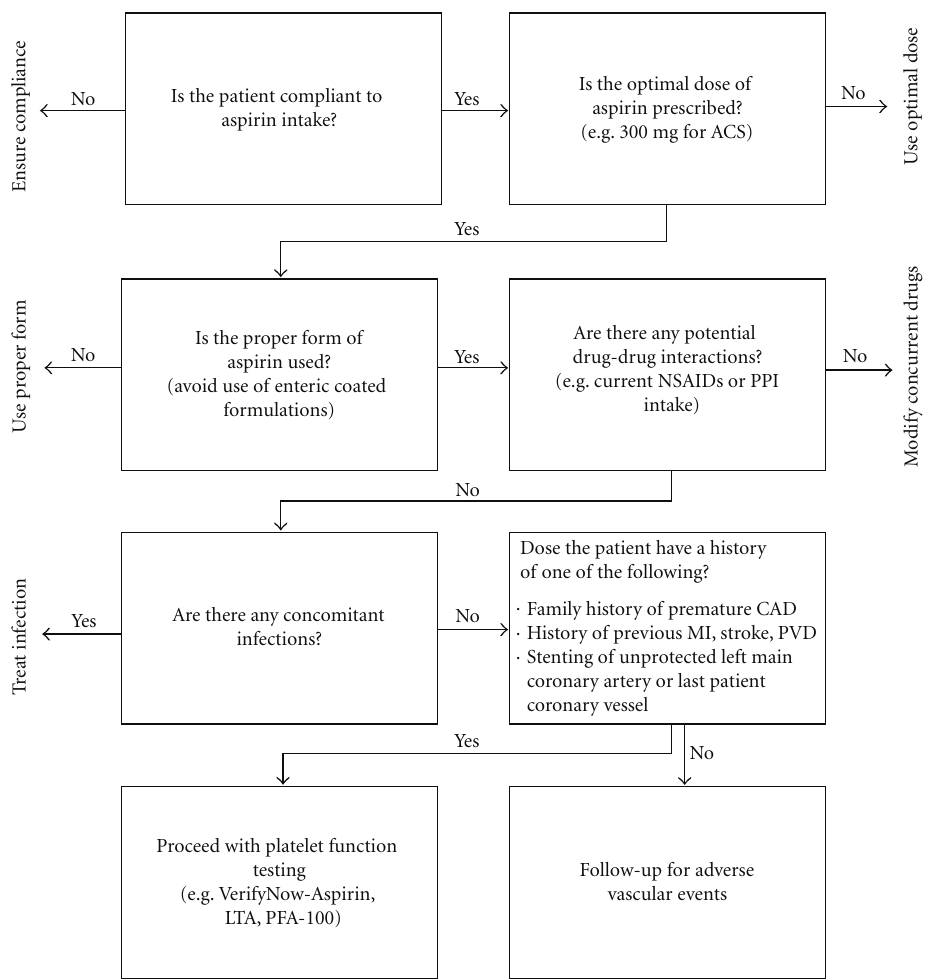
Figure 2: Algorithm highlighting approach to a patient with suspected aspirin resistance. ACS: acute coronary syndrome; NSAIDs: nonsteroidal antiinflamatory drugs; PPI: proton pump inhibitors; CAD: coronary artery disease; MI: myocardial infarction; PVD: peripheral vascular disease; LTA: light transmittance aggregometry; PFA: platelet function